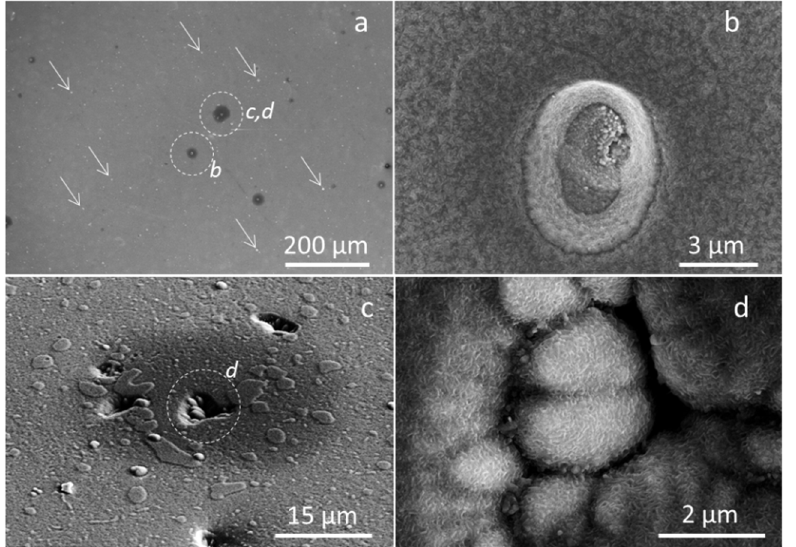
Figure 5. Plan-view SEM images of TiAlN hard coating oxidized at 800 °C for 60 min. SEM images were recorded at low ( a , c ) and high ( b , d ) magnification, while the image ( c ) was taken by tilting the sample by approximately 20°.